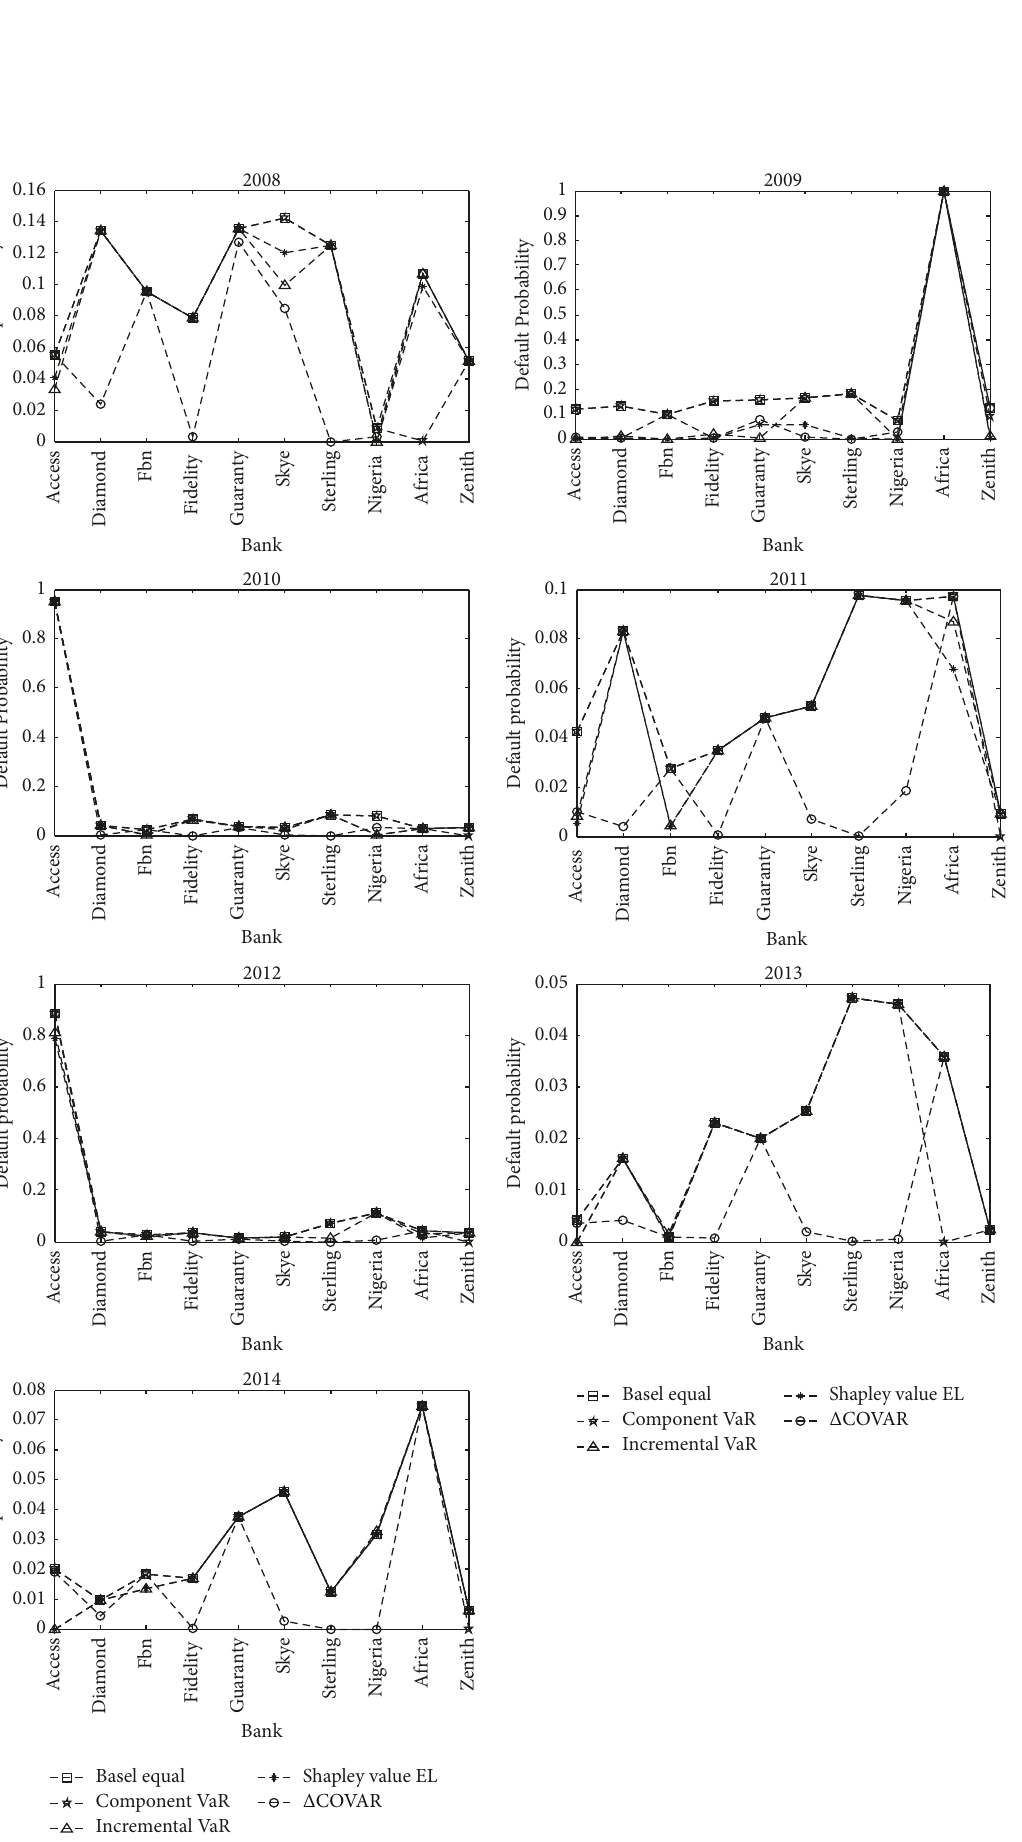
Figure 4: Individual bank total default probabilities under macroprudential capital requirements for the entire sample of 2008–2014. Within the banking system, Δ COVAR downsizes the average probability of default the